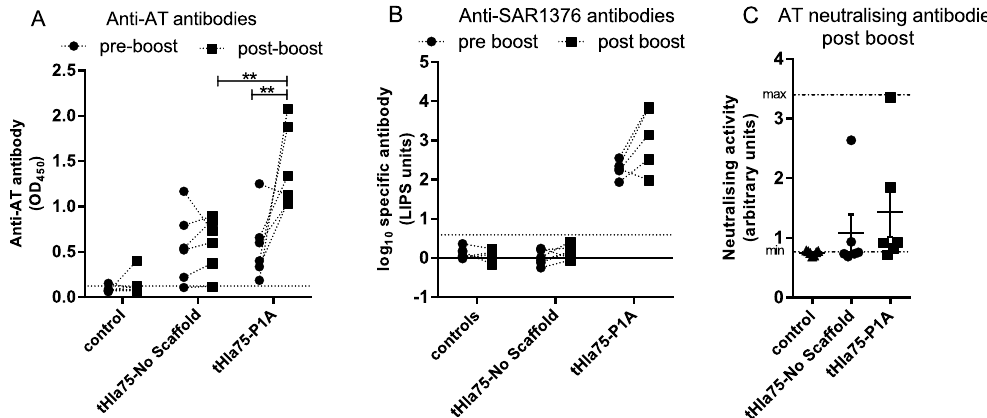
Figure 7. Impact of fusion of SAR1376 mutant P1A to truncated Hla on immunogenicity. ( A ) Anti-AT antibody levels. ( B ) Anti-SAR1376 antibody levels after vaccination of BALB/c mice with tHla75-no scaffold, tHla75-P1A, or empty vectors (control) as assessed respectively by ELISA and LIPS assay. Sera were collected pre boost (day 56 post Adenovirus prime) and post MVA boost (day 70 post prime). Dotted line: threshold for background response. ( C ) AT neutralizing activity of the antibodies was assessed post boost by Toxin Neutralisation Assay. Assay minimum and maximum levels were determined with mAb 8B7 and recombinant AT as described in Methods. ** p <